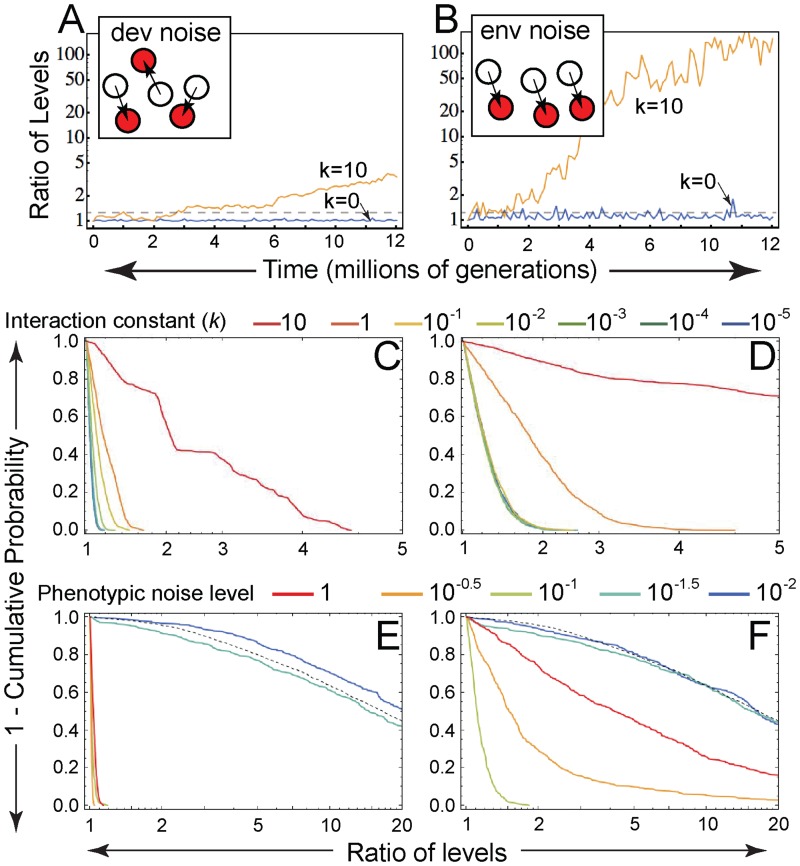
How the character of phenotypic noise affects corner stabilization in simulations.(A, B) The full evolutionary model (see Methods) was used to simulate time courses of the population center of mass (solid lines) for two different values of the interaction constant, k, subject to either pure developmental noise (A) or pure environmental noise (B). The proximity of the corner within which epistasis is expected is indicated by the horizontal dashed lines drawn at a distance of σμ = 0.1 from the corner. (C–F) The probability that the population is at least a given distance from the corner for various values of k (C, D), and various levels of developmental and environmental noise, σdev and σenv, respectively (E, F). In A and C, the phenotypic noise level is σdev = 0.1; in B and D it is σenv = 0.1. In E and F, k = 10−4, and the black dashed line is the limiting case of no phenotypic noise (σdev = σenv = 0). Mutational step size in C–F was σμ = 1. Throughout, data in the left and right columns correspond to purely developmental and purely environmental phenotypic noise, respectively.